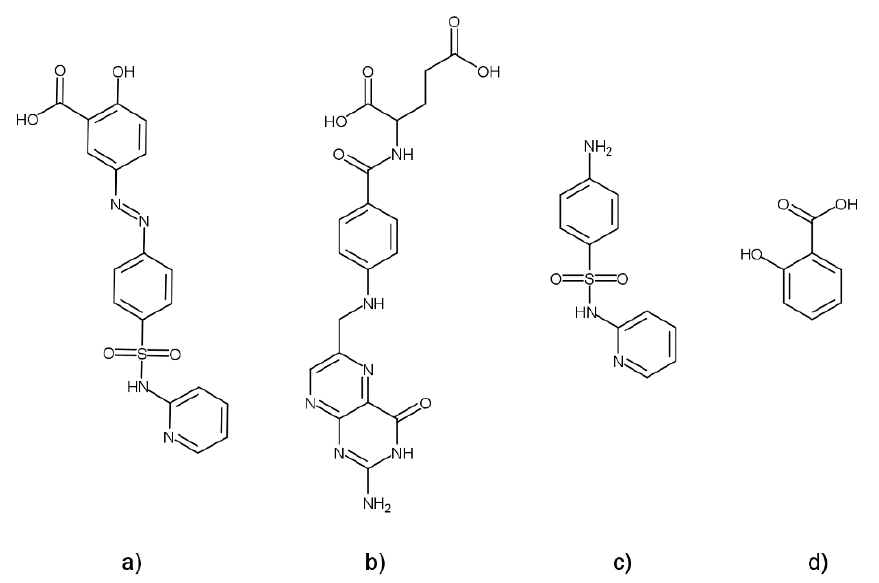
Figure 1. Structures of ( a ) sulfasalazine (SASP), ( b ) folic acid (FA), ( c ) sulfapyridine (SP) and ( d ) salicylic acid (SA).